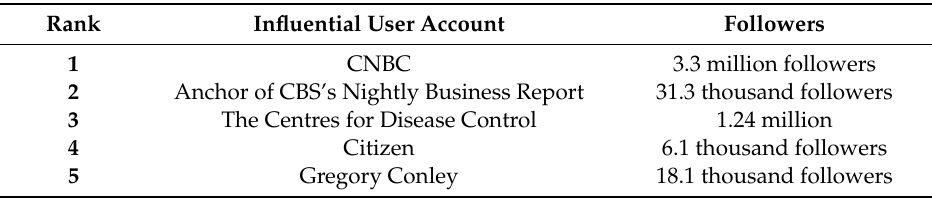
Table 6. Influential users ranked by betweenness